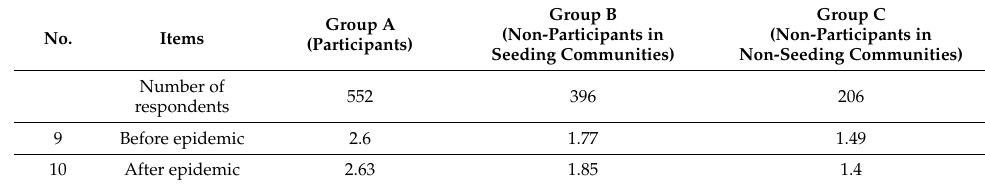
Table 3. Mean values of optimism.